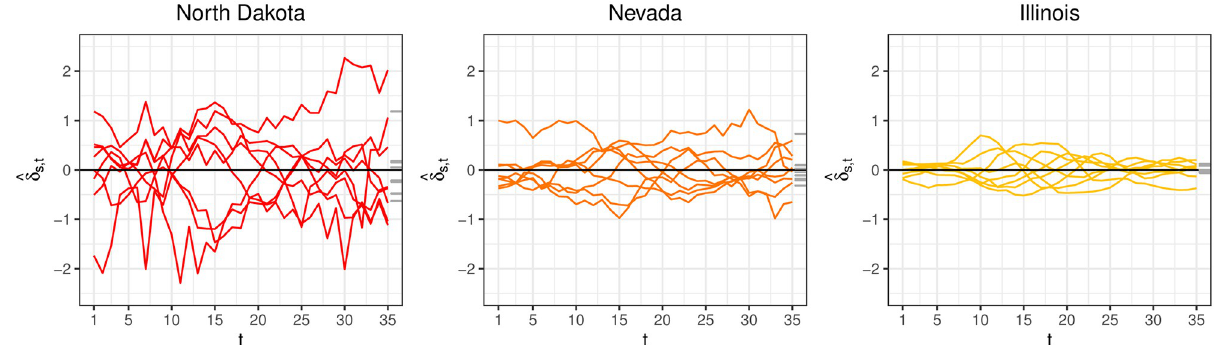
(grey tick marks) for North Dakota, Nevada, and Illinois. North Dakota exhibits more season-to-season variability in s . s